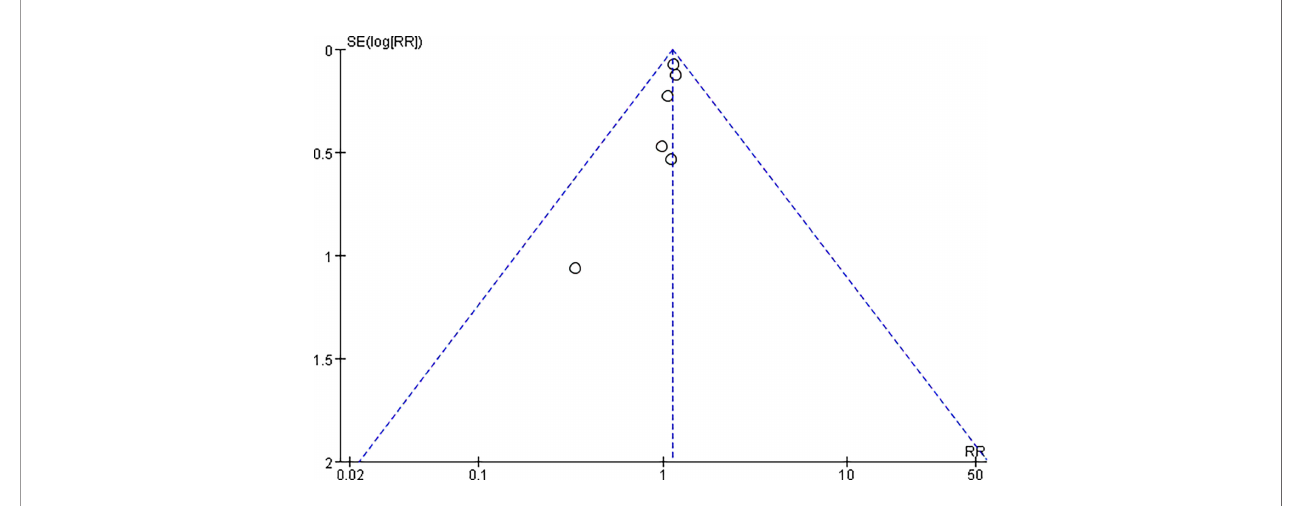
FIGURE 3 | Publication bias of the